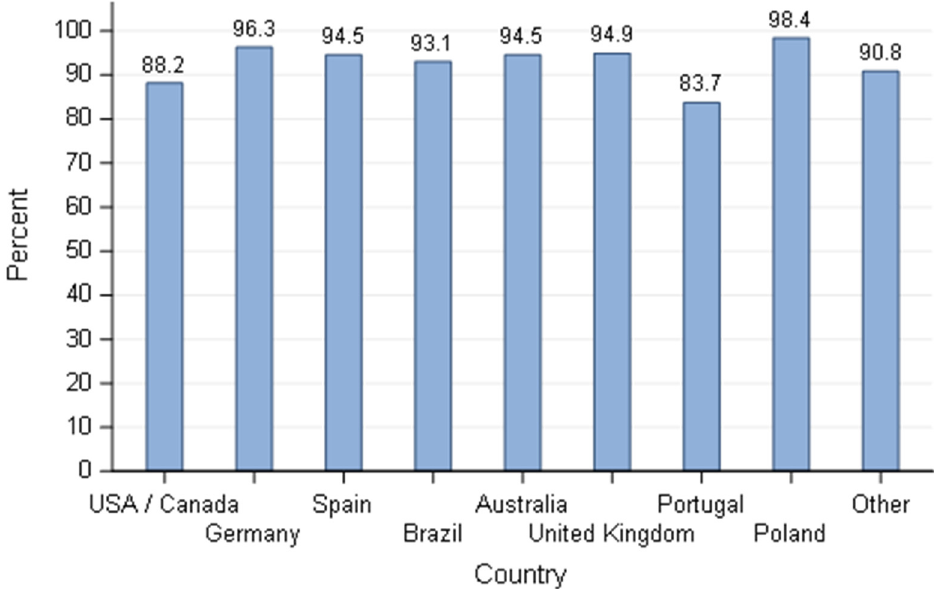
Figure 9. Use of ultrasound as a method to confirm pregnancy in breeding bitches based on breeders’ responses by country—responders stating to do a pregnancy diagnosis ( n = 585). If some common methods were observed for estimation of breeding time and pregnancy diagnosis, the procedures to estimate the time of parturition were globally more diverse across the countries (Figure 10). However, regardless of countries, breeders applied in similar proportion (around 20%) the calculation from the date of breeding or ovulation, observation of behaviour and the drop-in the rectal temperature around whelping time to predict the day of parturition.